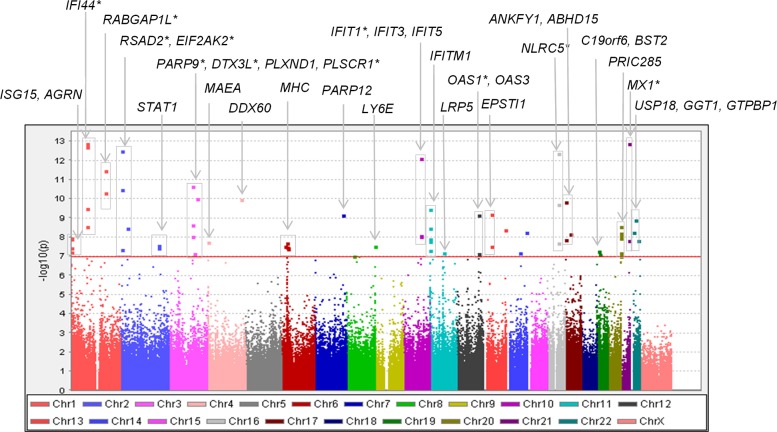
Manhattan plot of the DNA methylation sites associated with anti-dsDNA autoantibody production.Results are based on multivariable linear regression for the combined dataset. The red line indicates a significance level of p<1.07E-07. Points above the red line that are unannotated are not within a known gene. Genes marked with an asterisk (*) were associated with anti-dsDNA autoantibody production using the discovery/replication study design.